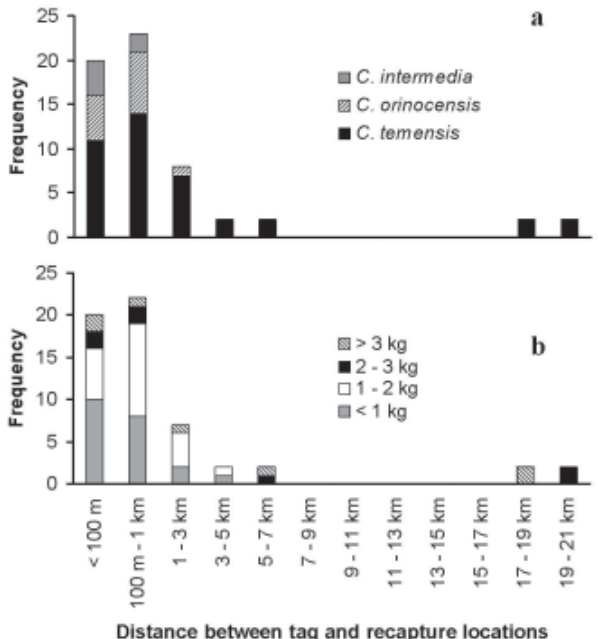
Fig. 3. Frequency histograms of distance between tag and recapture locations by (a) species and (b) size class (weight) at time of recapture. Note: distance range is not standardized for the first two categories to illustrate localized